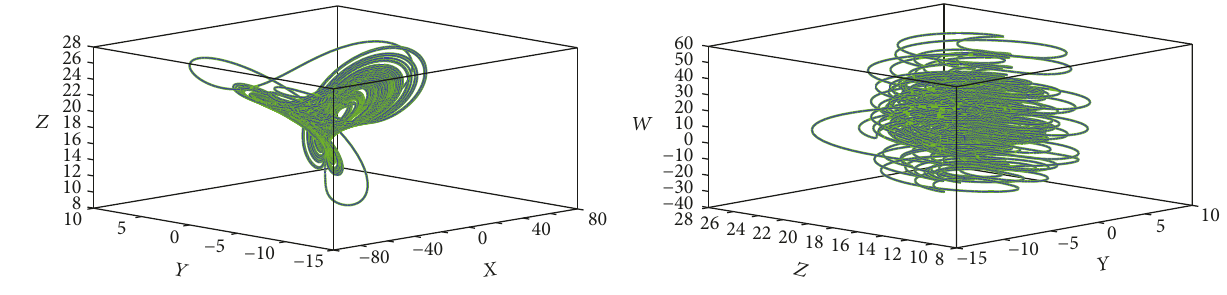
Figure 3: 3D phase portraits of the NCS 3 system.